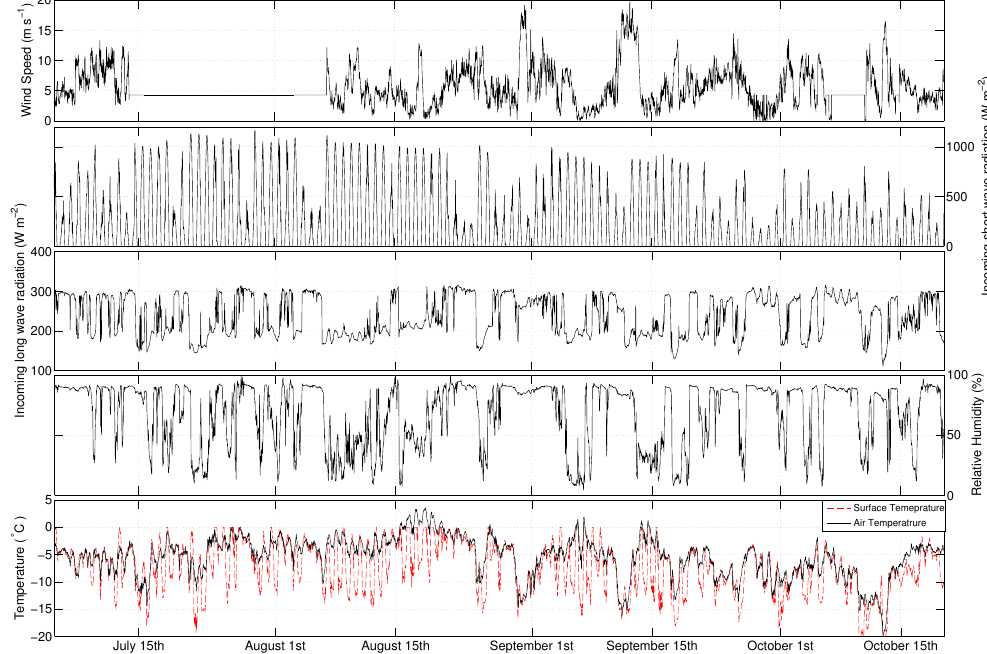
Fig. 2. Meteorological data recorded by the AWS in summer 2012 and surface temperature calculated using measured infra-red surface emissions.